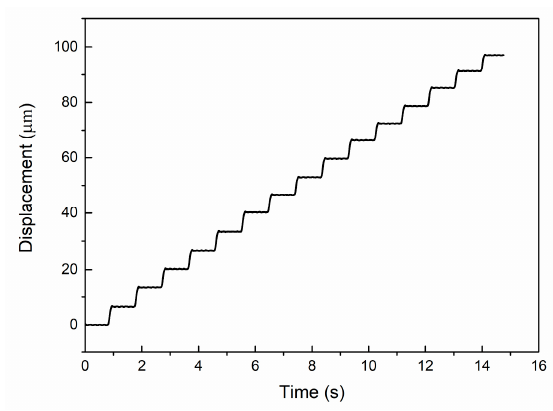
Figure 15. The performance of the piezoelectric actuator.